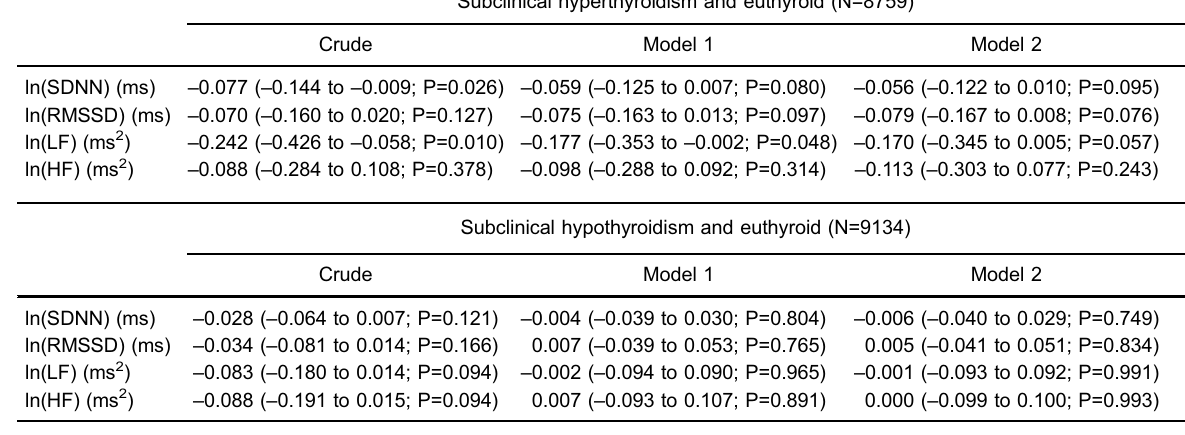
Table 3. Beta coef fi cients and 95% con fi dence intervals of multivariate linear regression models, evaluating the association between heart rate variability and subclinical hyperthyroidism (SCHyper) or subclinical hypothyroidism (SCHypo) versus euthyroid